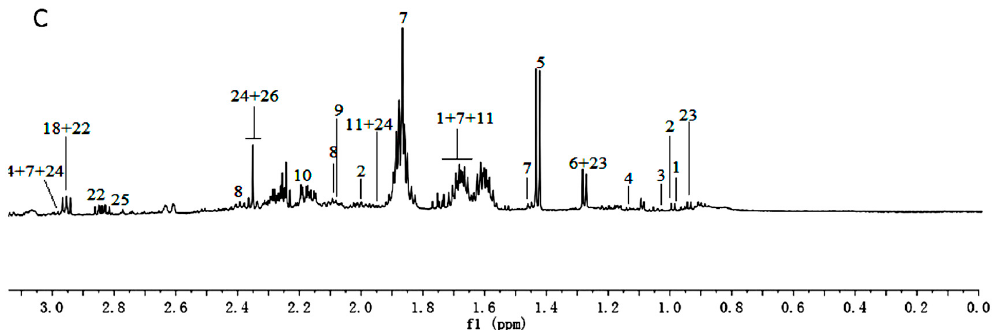
Figure 2. 1 H-NMR spectra (600 MHz) of aqueous methanol fractions in PR from FJZR in low field region ( A ); middle field region ( B ) and high field region ( C ). NMR solvent: CD 3 OD:KH 2 PO 4 buffer in D 2 O 1:1. Table 1. Metabolites detected by 1 H-NMR in PR from different cultivated fields.